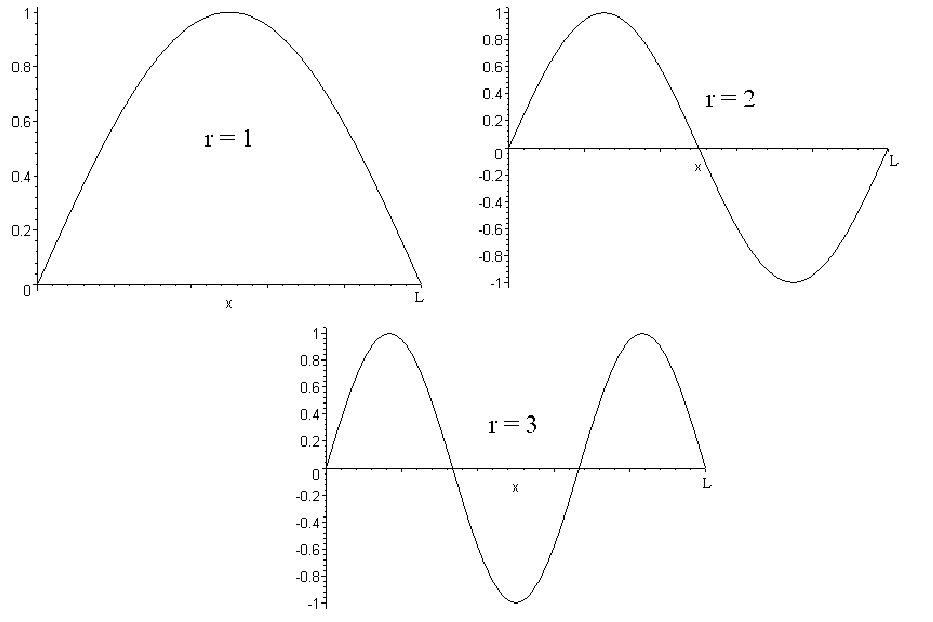
Fig. 3. Shape functions of the Classical Theory for the truss element to the first three vibration modes.